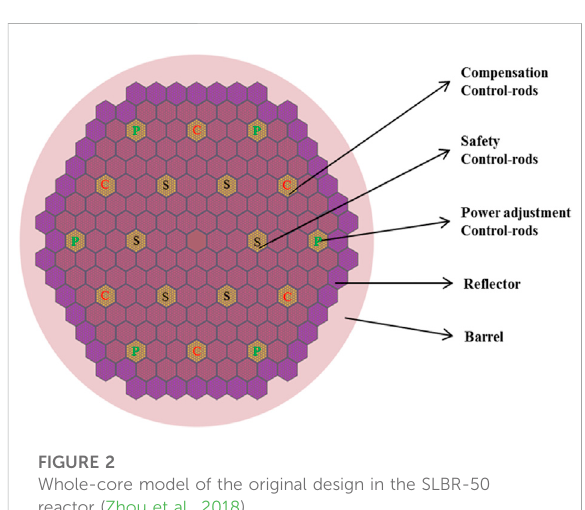
FIGURE 2 Whole-core model of the original design in the SLBR-50 reactor (Zhou et al.,